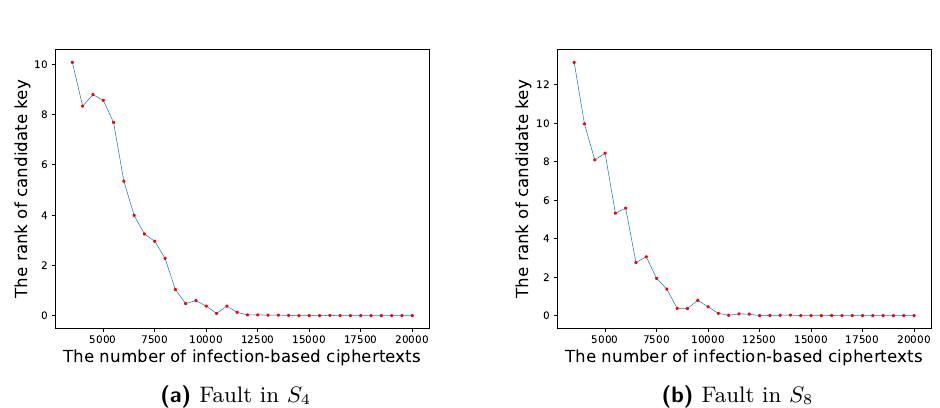
Figure 5: Simulation results of Algorithm 4 on DES. The simulation is performed inde- pendently when the fault is injected in S